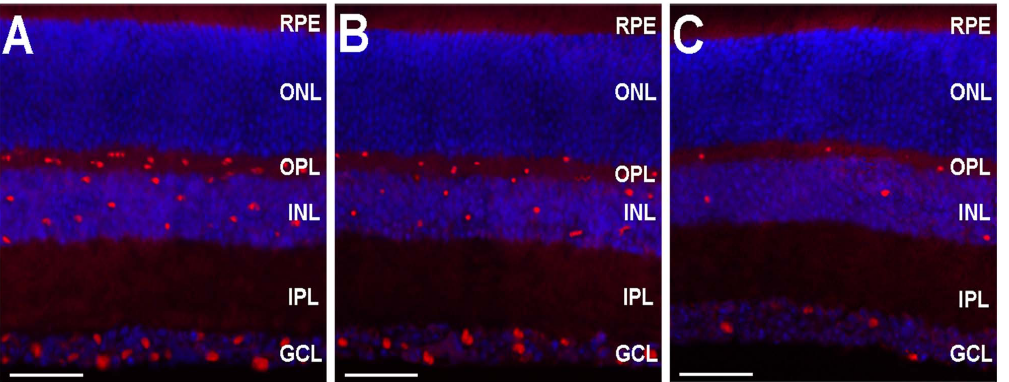
Figure 2. Expression of 15-LOX-1 gene transfers into the mouse retina. This figure shows the expression of 15-LOX-1 gene transfer in the retinas of 12-day-old C57BL/6J mice, 5 days after intravitreous injections of approximately 1.0 6 10 9 plaque formation unit of Ad-15-LOX-1-GFP or Ad- GFP. Retinas obtained from LOX-GFP group, OIR-LOX-GFP group and OIR-GFP group mice were immunostained with an antibody for 15-LOX-1. Immunofluorescence staining indicated that the 15-LOX-1 protein is more strongly expressed in retinas from LOX-GFP group (A) and OIR-LOX-GFP group (B) mainly in the outer plexiform layer (OPL), inner nuclear layer (INL) and ganglion cell layer (GCL) than in retinas from OIR-GFP group (C). Cell nuclei were stained with 4 9 , 6-diamidino-2-phenylindole (DAPI). Images A-C were taken at 400 6 magnification for optimal comparison, scale bars=35 um.